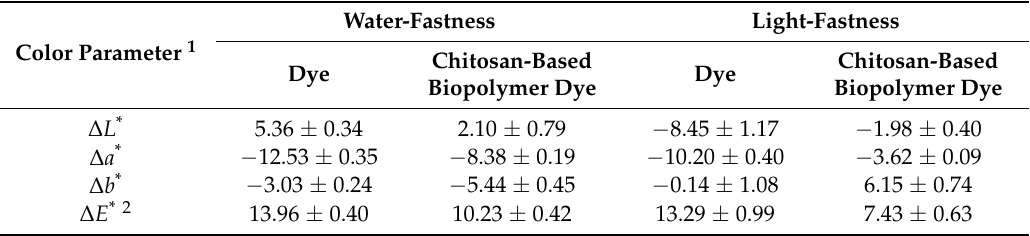
Table 4. Color fastness of poplar veneers dyed with Acid Red GR and chitosan-based biopolymer dye.